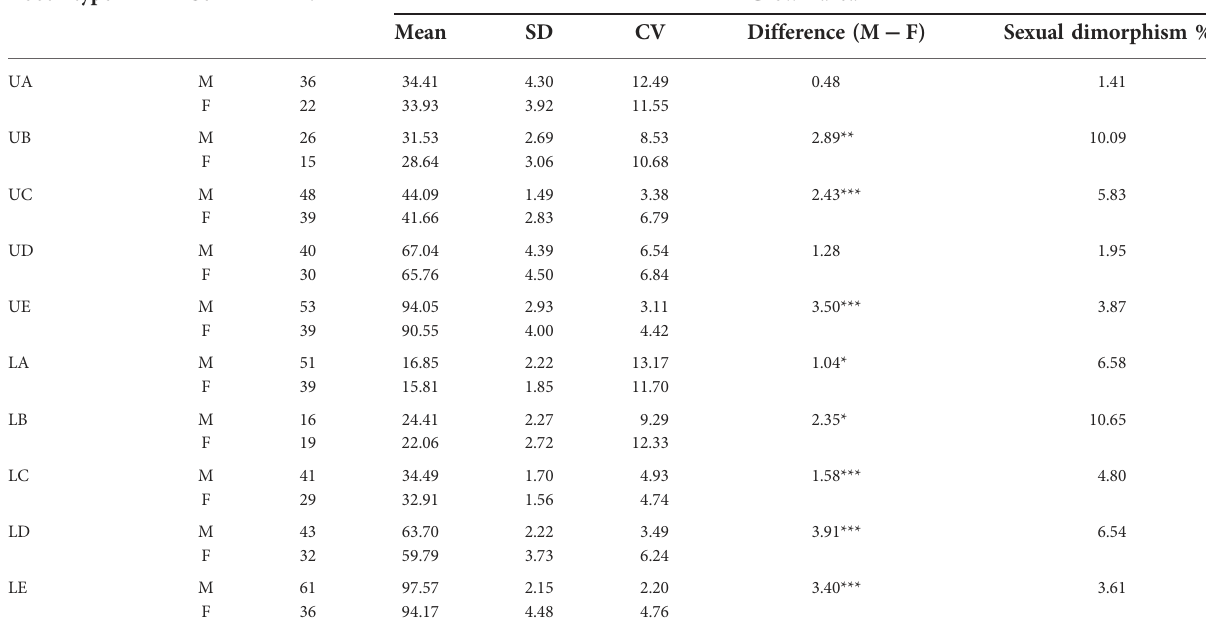
TABLE 8 Crown area and sexual dimorphism of the total sample. Tooth